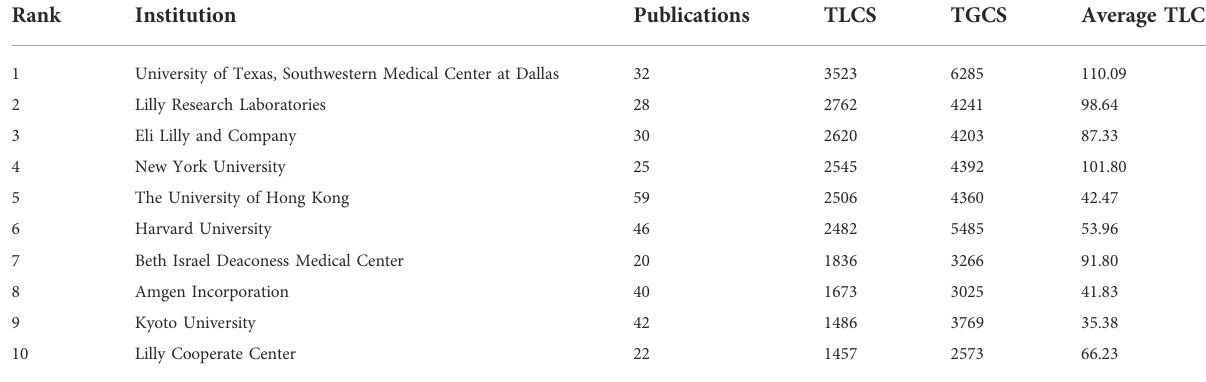
TABLE 2 Top ten institutions with the highest TLCS.